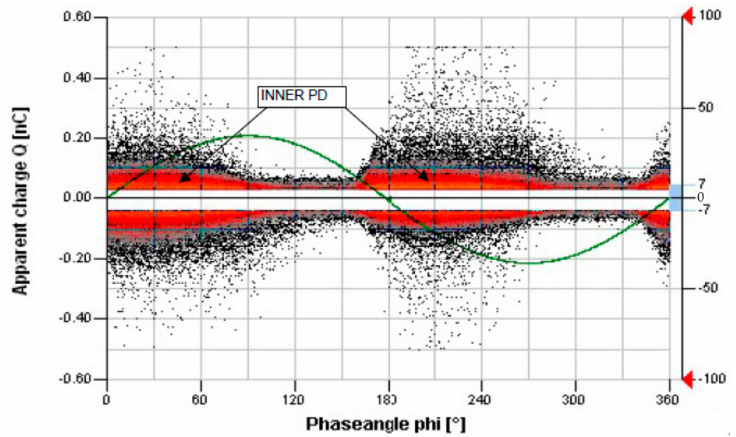
Figure 6. PD activity in Phase U